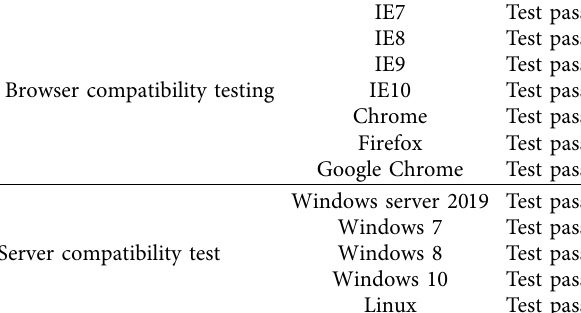
Table 6: Compatibility test